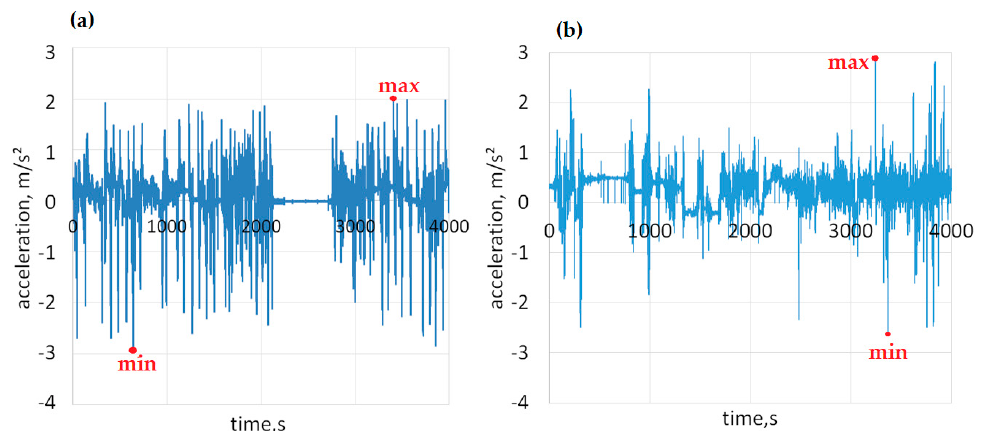
Figure 9. Longitudinal acceleration profiles during regular travels ( a ) for an urban bus and ( b ) for a coach.